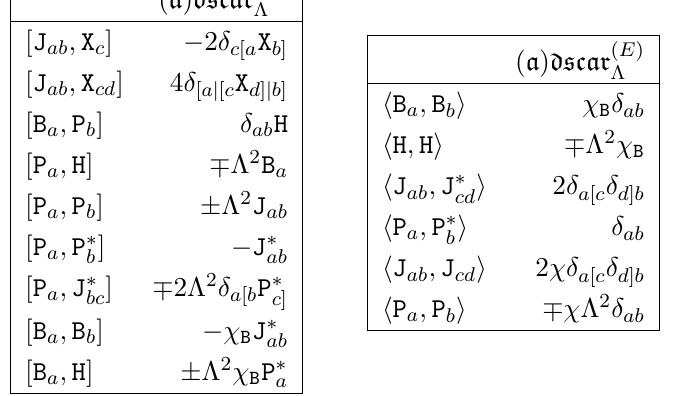
Table 6 . Double extension based on the AdS-carrollian (upper sign) and dS-carrollian (lower sign) algebra. The vector X a stands for B a ; P a ; P (cid:3) spanned by boosts and spatial translations. From invariance with respect to the rotations and nondegeneracy follows that the invariant metric on g = f B